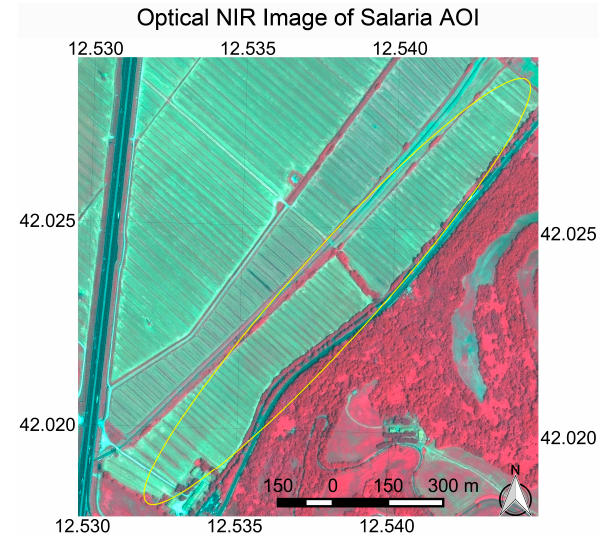
Figure 45. Pleiades image acquired on 22 May 2014 over the Salaria AOI, pan-sharpened to 0.5 m spatial resolution. NIR, R and G displayed as R, G and B respectively. Yellow ellipse shows location of the residue of the ancient Via Salaria. Pleiades data provided by the European Space Agency.